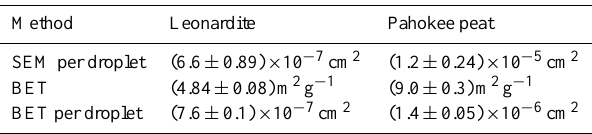
Table 2. Surface area estimates applying analysis of scanning electron microscopy (SEM) images and Brunauer–Emmett–Teller (BET) gas adsorption